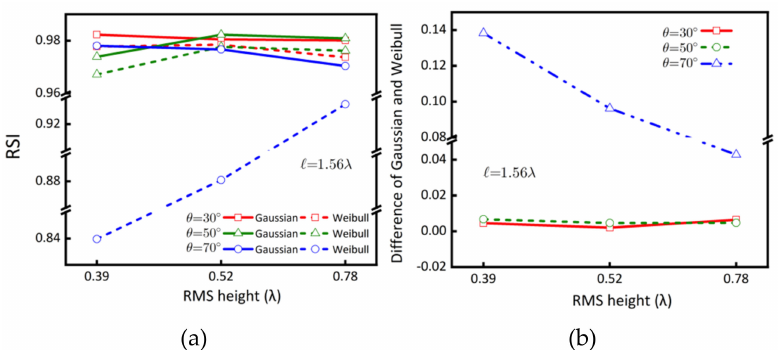
Figure 11. Comparison of RSI between Gaussian and Weibull HPDs surface as a function of RMS height, at three look angles of 30, 50, and 70 degrees; ( a ) RSI, ( b ) Difference of RSIs.